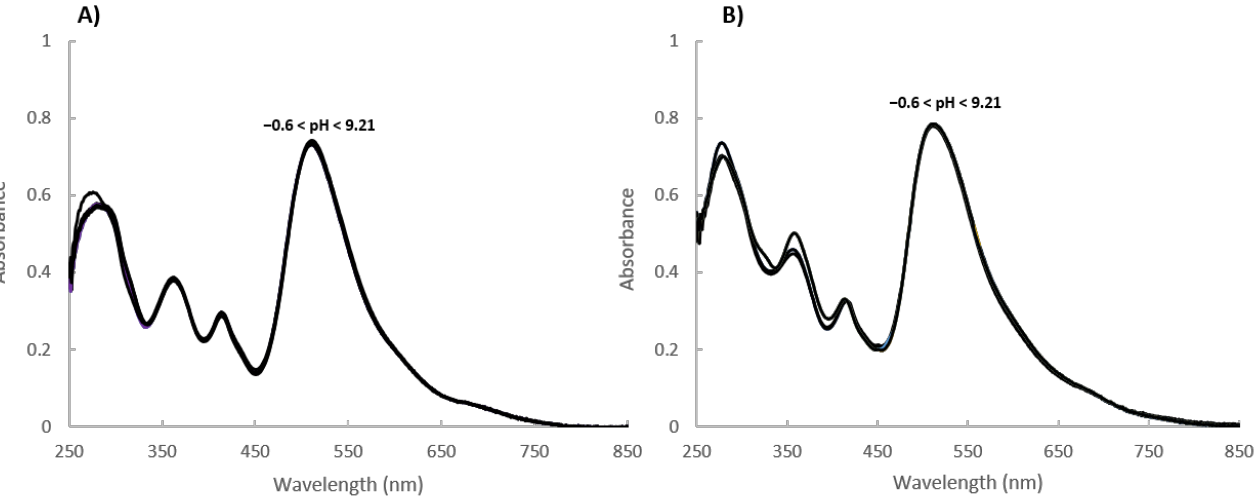
Figure 3. UV − Visible spectra of ( A ) trans-cinnamate pyranoflavylium ester (dye 3) and ( B ) 4-bromo cinnamate pyranoflavylium ester (dye 4) in aqueous solution at different pHs. Regarding 4-dimethylamino and 4-amino cinnamate pyranoflavylium esters (dyes 1